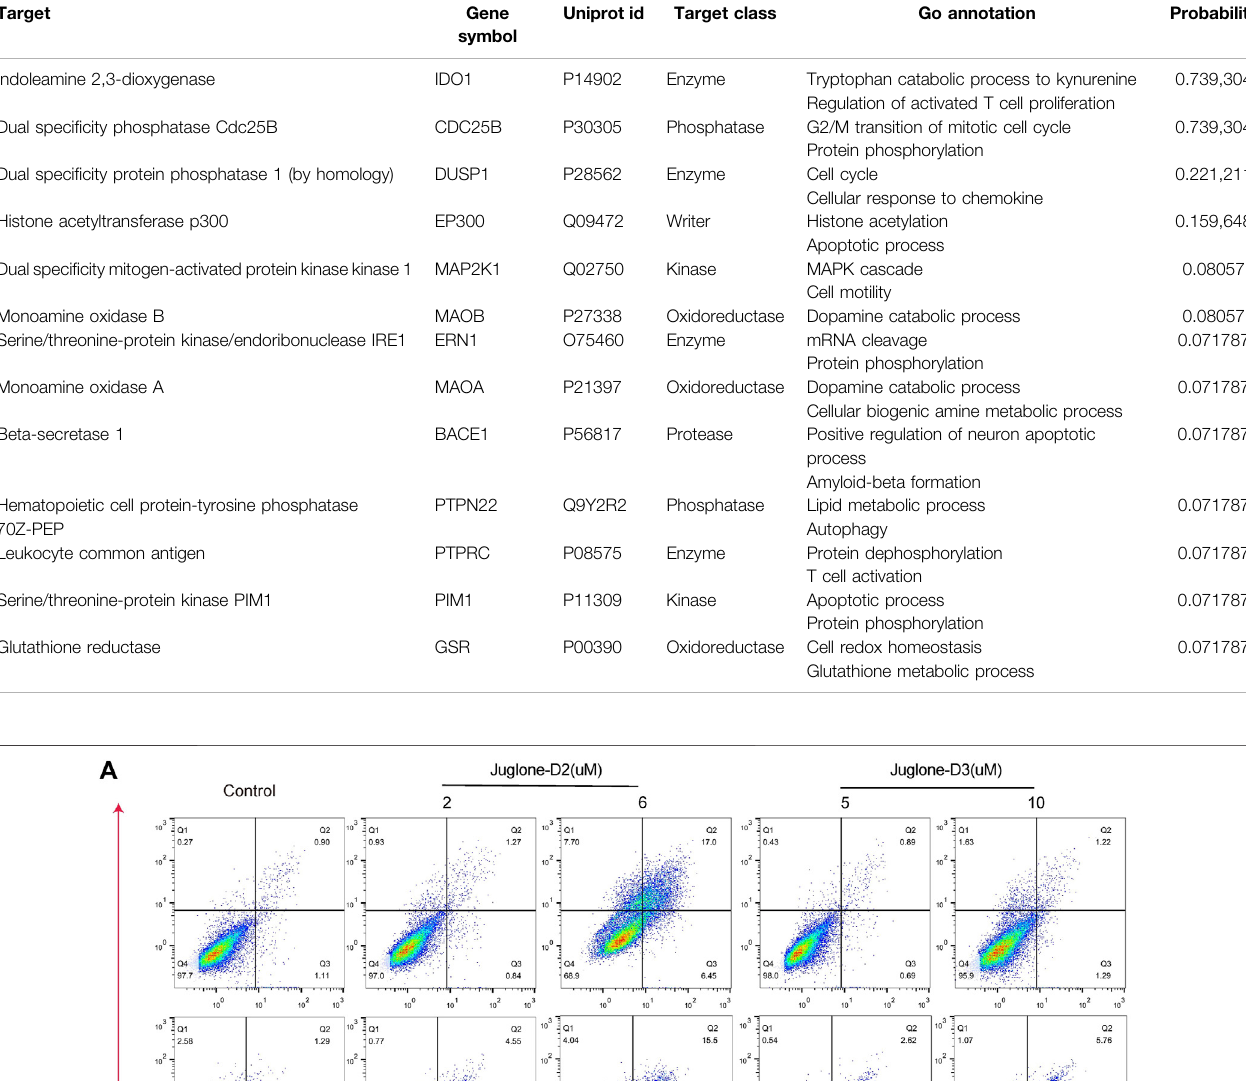
TABLE 2 | Juglone targets from SwissTargetPrediction.